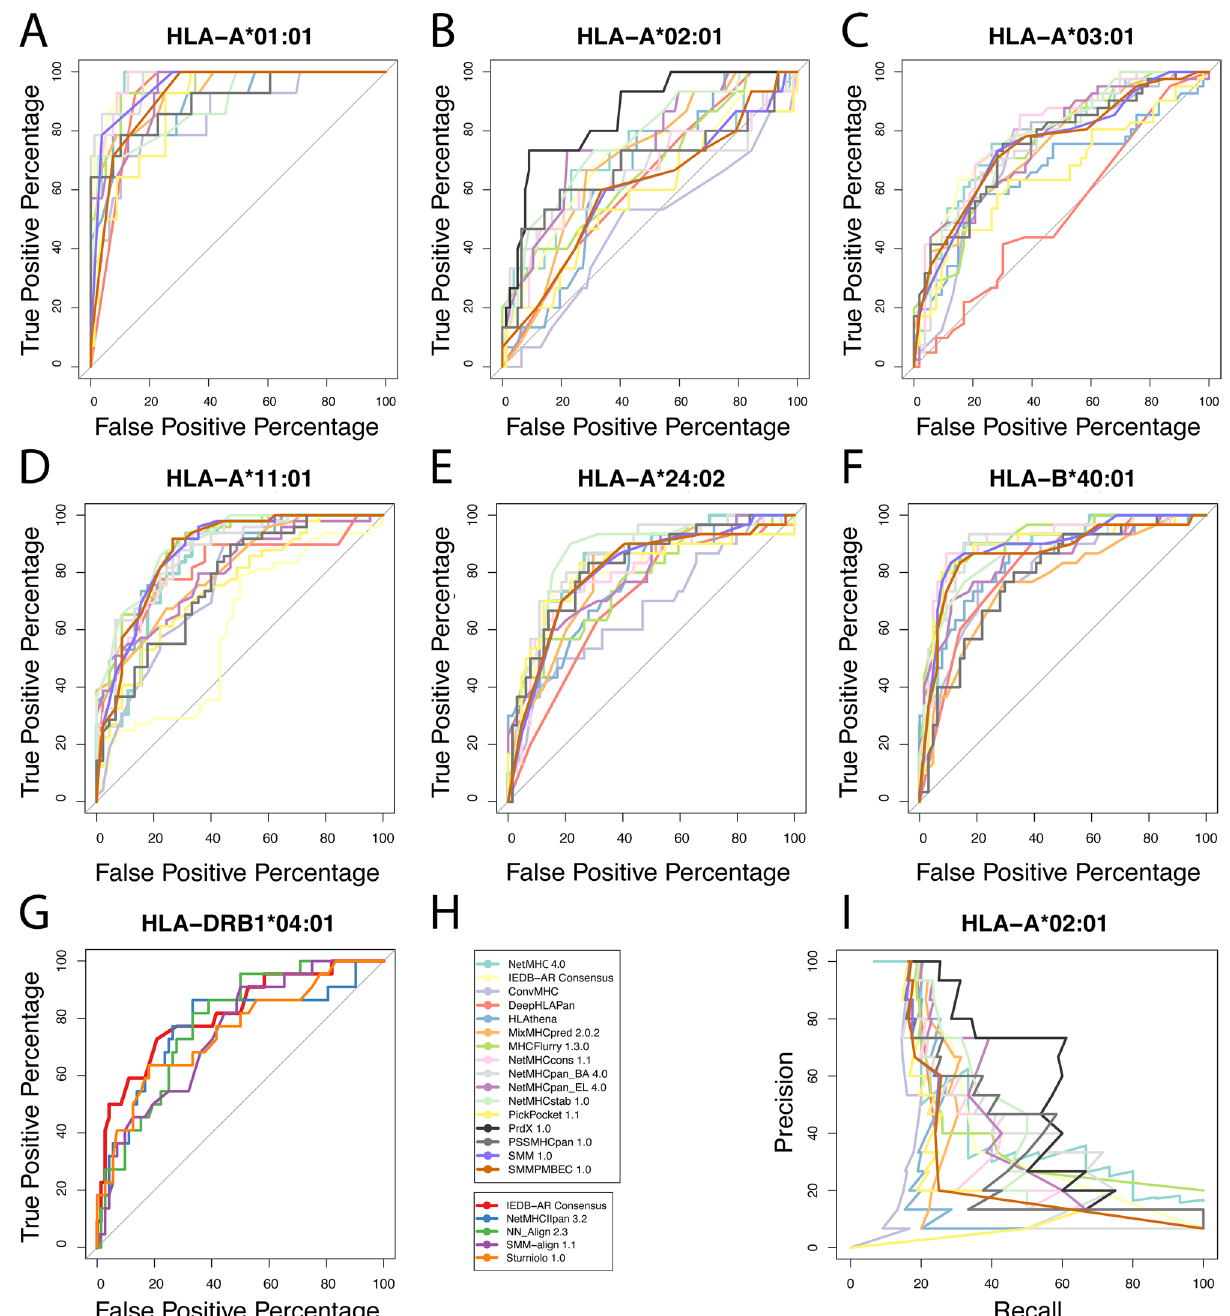
Figure 1. ROC curves for each allele that bound more than 10 peptides stably (subplots A , B , C , D , E , F , G ), ( H ) tools used in the benchmark, upper box—HLA class I, lower box—HLA class II (IEDB-AR Consensus is available for both), ( I ) precision-recall curves for HLA-A*02:01. Corresponding area under curve (AUC) values are listed in Table